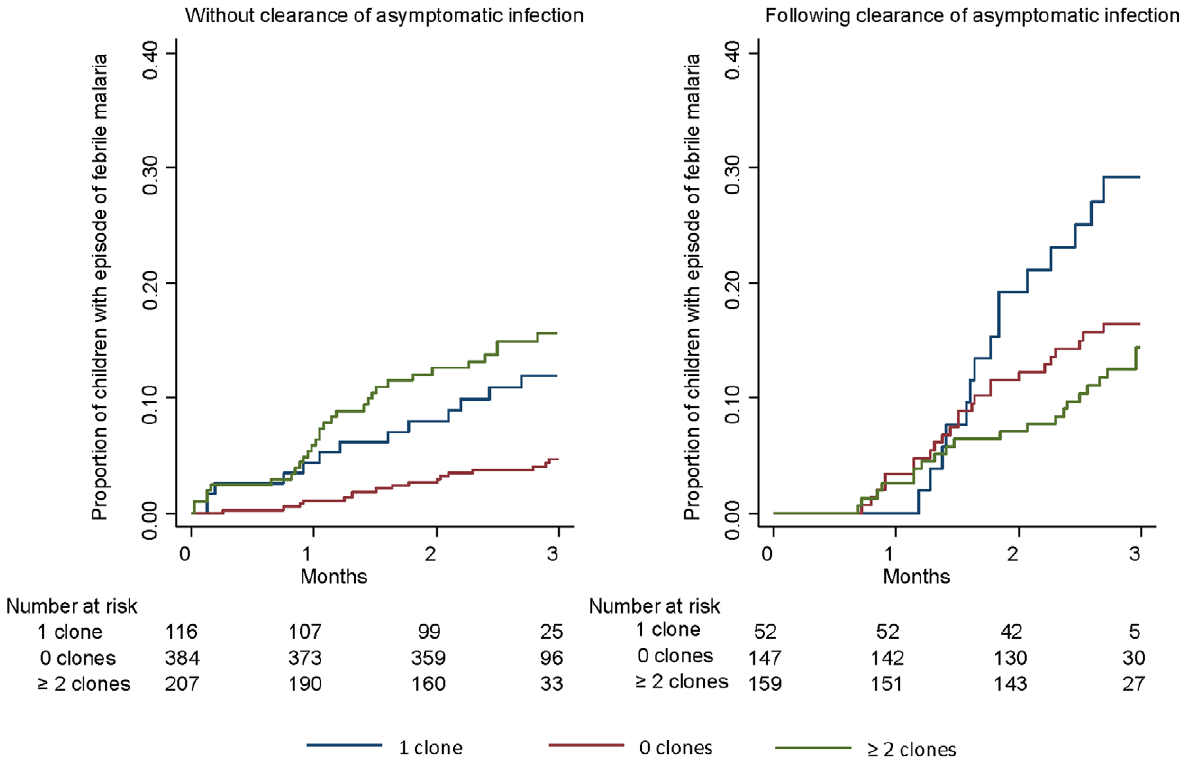
Figure 3. Kaplan Meier estimate of time to subsequent clinical episode without and with treatment following survey. doi:10.1371/journal.pone.0016940.g003 PLoS ONE |